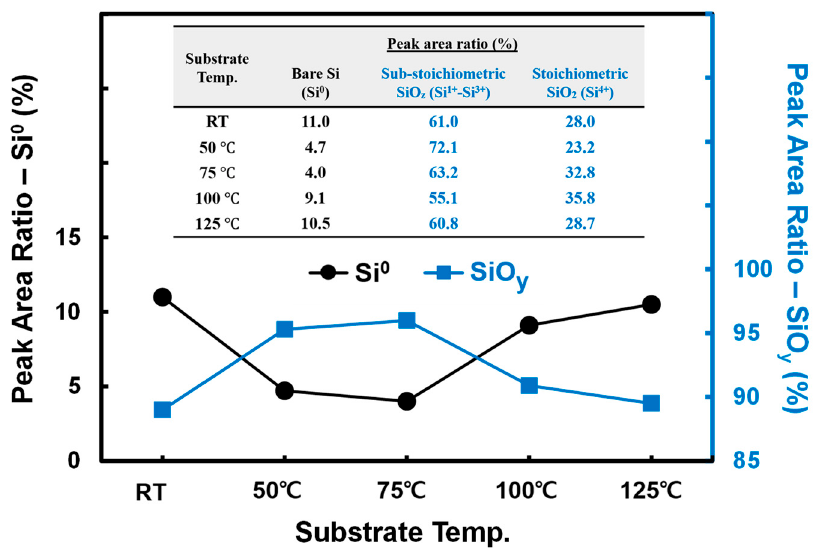
Figure 4. Peak area ratios of Si states calculated by measured Si 2p doublet spectra.